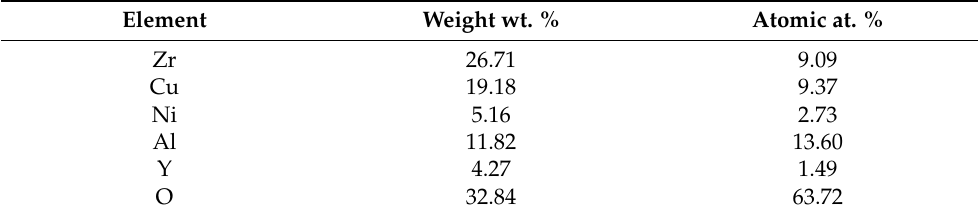
Table 1. EDS results of the nanopillar